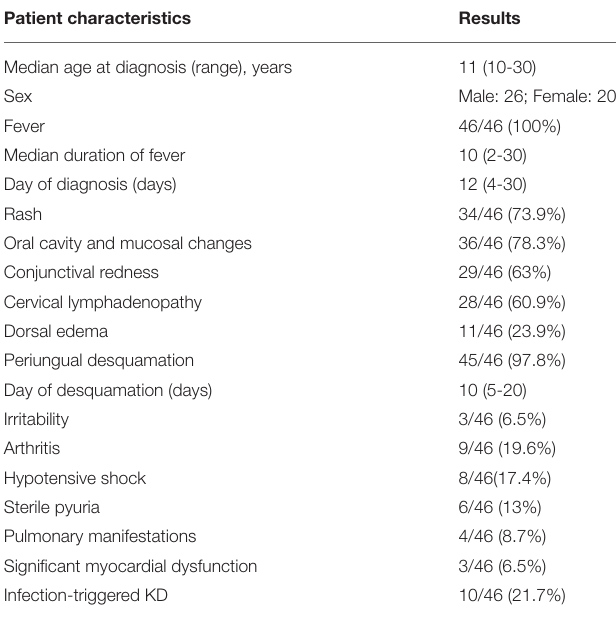
TABLE 1 | Clinical features of children with Kawasaki disease (KD) aged > 10 years at the time of